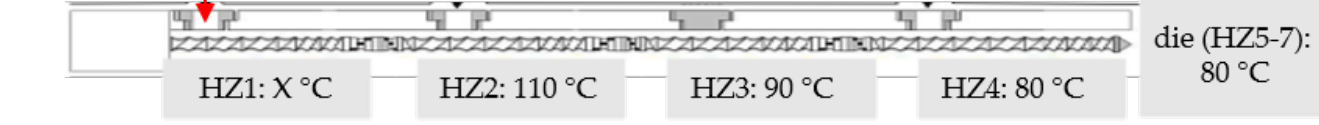
Figure 14. Extruder screw, temperatures of heating zones (HZ), and feeding section (red arrow).